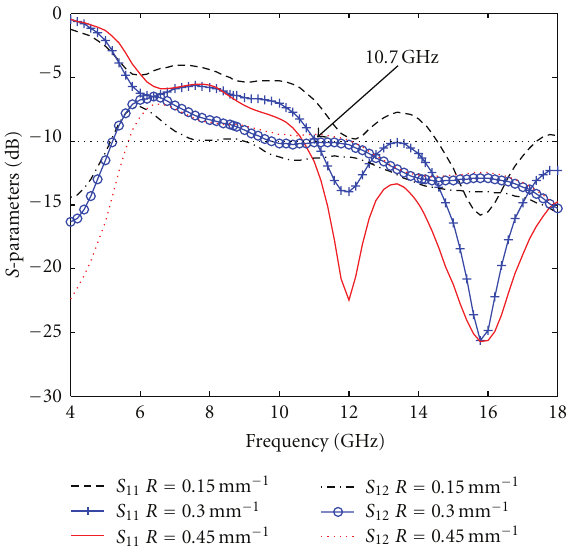
Figure 12: S -parameters with various opening rates R .